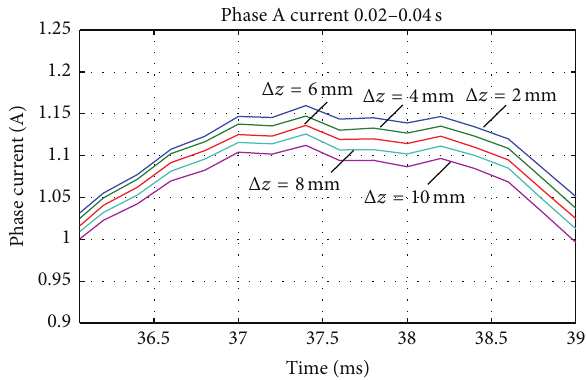
Figure 15: Enlarged view of the stator phase current (peaks).